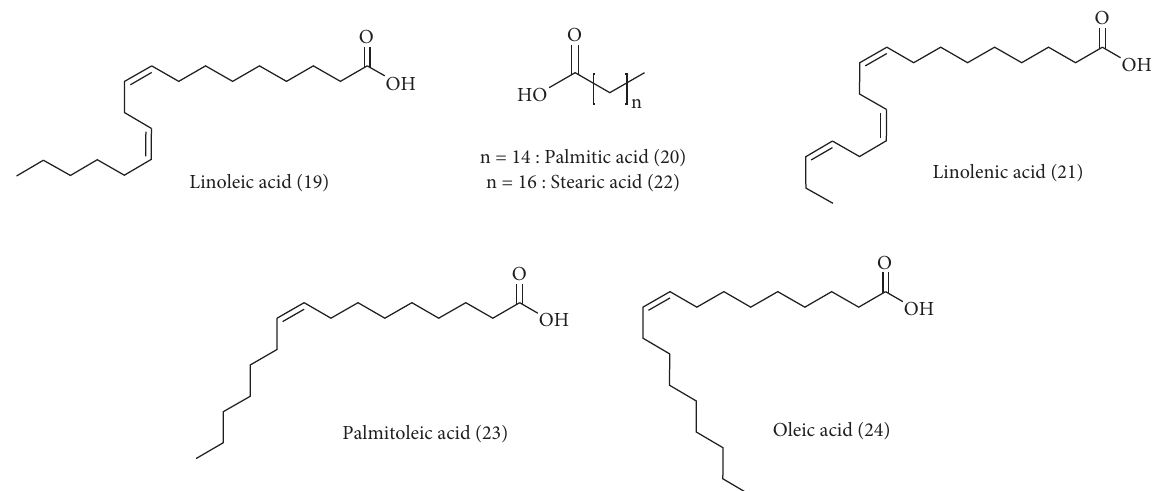
Figure 3: Structure of fatty acid compounds detected in C.